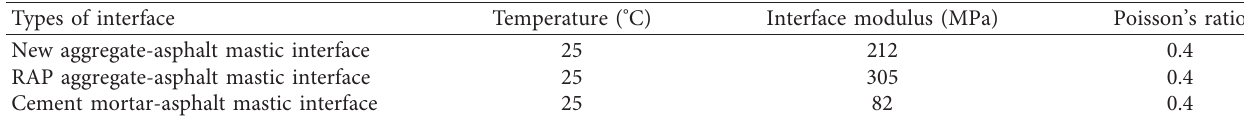
Table 6: Interfacial modulus of warm-mixed reclaimed semiflexible